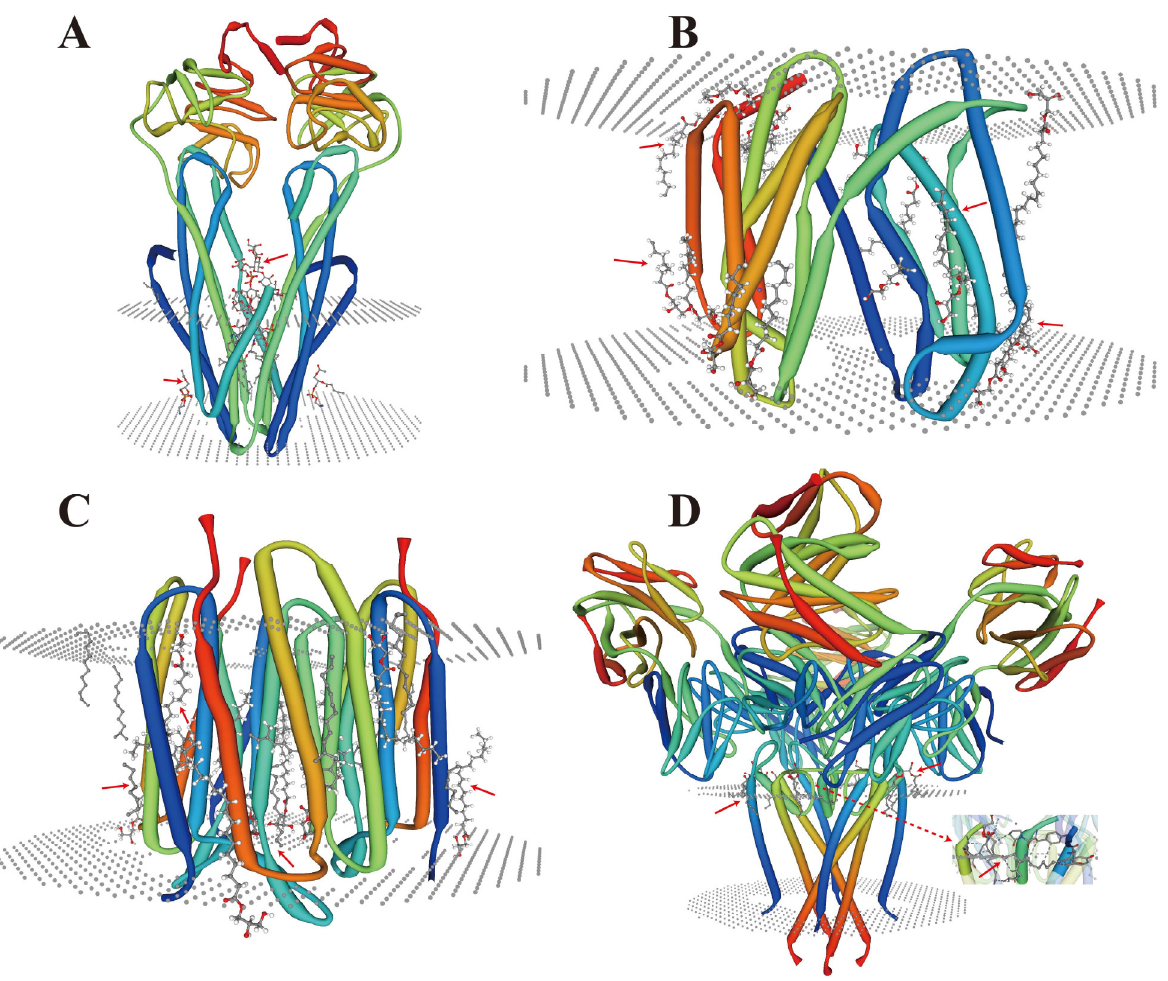
Figure 7. Crystal structure analysis of lipid-membrane protein interactions. ( A ) Escherichia coli ( E. coli ) MsbA in complex with LPS and inhibitor G907 (PDB ID: 4KSC) [147]; ( B ) Lipid II flippase MurJ, outward-facing conformation in Thermosipho africanus (PDB ID: 6NC9) [148]; ( C ) Steady-state-SMX dark state structure of the bacteriorhodopsin in Halobacterium salinarum (PDB ID: 6RQP) [149]; ( D ) Structure of the KcsA-G77A mutant or the 2,4-ion bound configuration of a K(+) channel selectivity filter in Streptomyces lividans (PDB ID: 6NFU) [150]. PDB, Protein Data Bank; MsbA, an essential ATP-binding cassette transporter in Gram-negative bacteria; LPS, lipopolysaccharide; MurJ, the lipid II flippase in E. coli . The red arrows indicate the positions where lipids and membrane proteins interact with each other.